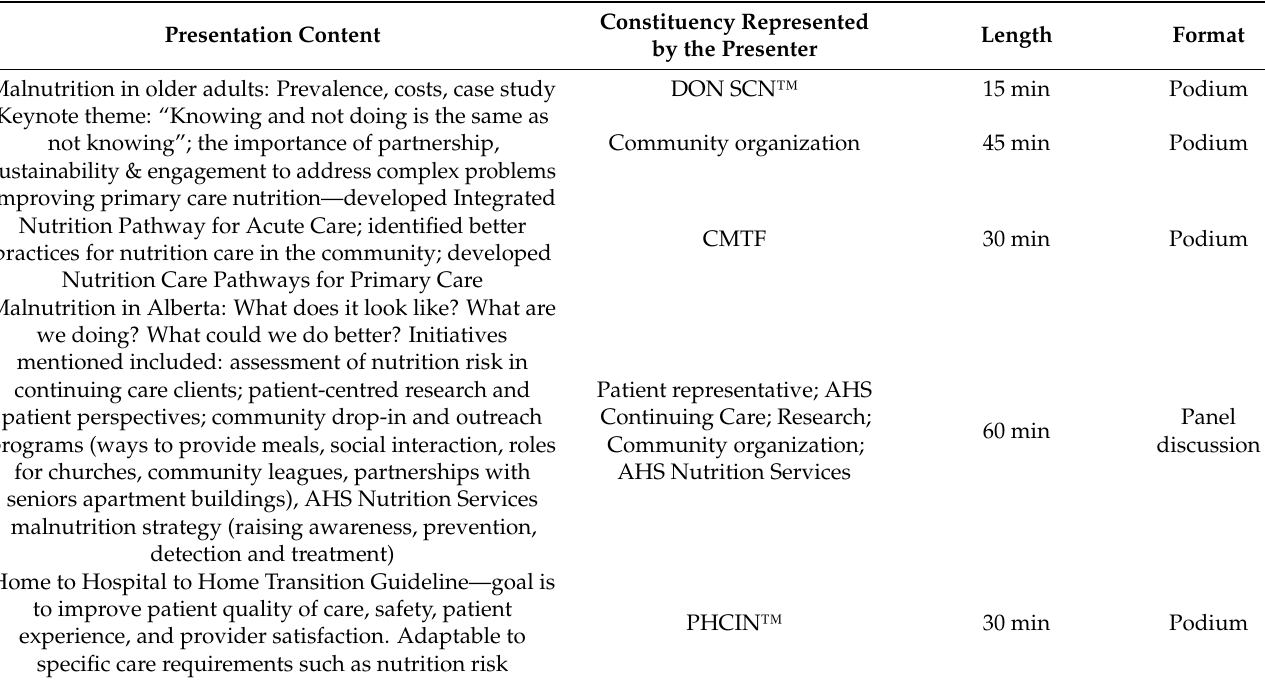
Table 2. Presentations at the